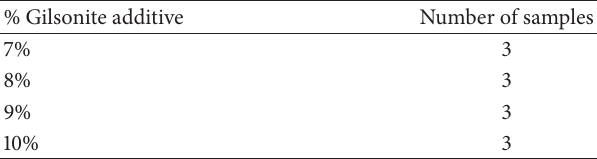
Table 7: Proportion of the aggregate, asphalt content, and number of samples.